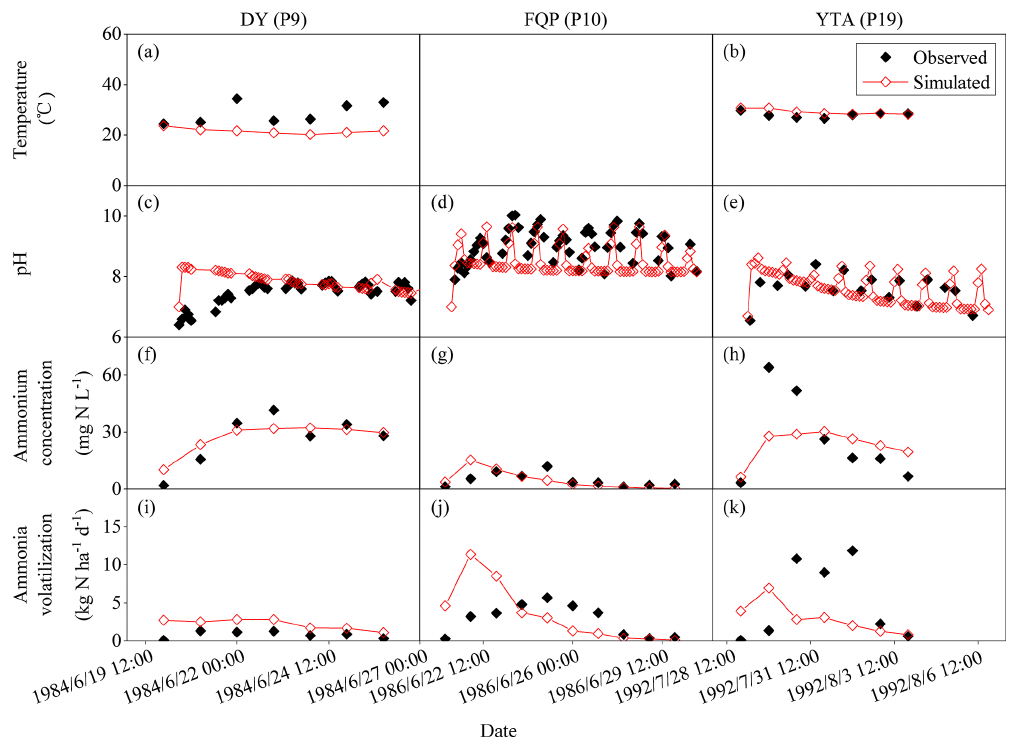
Figure 5. Observed and simulated temperatures; pH and ammonium concentrations of floodwater; and daily ammonia volatilization from the urea application for DY, FQP, and YTA. The definitions of the case codes refer to Table 2. The sites are Danyang (DY), Fengqiu with rice paddy fields (FQP), and Yingtan